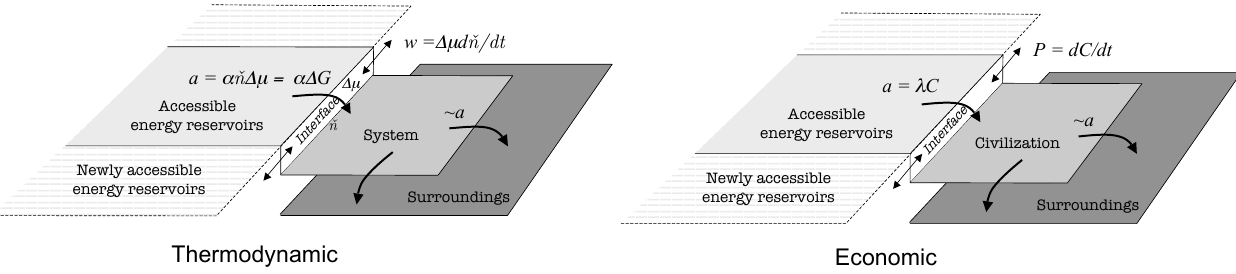
Fig. 1. Schematic for the thermodynamic evolution of an open system, and its hypothesized economic rep- resentation. Energy reservoirs, civilization, and its surroundings lie along distinct constant potential surfaces. The number of material units ˘ n defining an interface between civilization and energy reservoirs determines the speed of downhill energetic flow at rate a , in proportion to a fixed specific potential difference ∆ µ and rate coefficient α . The interface itself grows or shrinks at rate w due to a net flux convergence into civilization. In a positivefeedback,interfacegrowthatrate d ˘ n/dt expandsenergeticflows a byextendingcivilization’saccessto previously inaccessible energy reservoirs at rate da/dt . Fiscally, wealth C is proportional to both the interface size ˘ n and the rate of primary energy consumption a . The GWP P represents the net expansion of wealth at rate dC/dt due to interface growth. C and a are linked through a constant λ . See the text and Garrett (2011) for details.